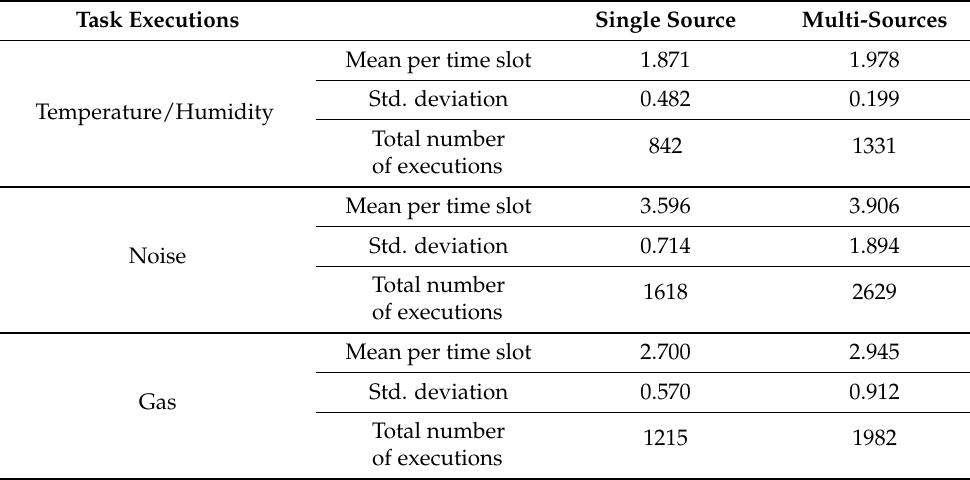
Table 6. Energy allocator performance for single- and multi-source energy harvesting